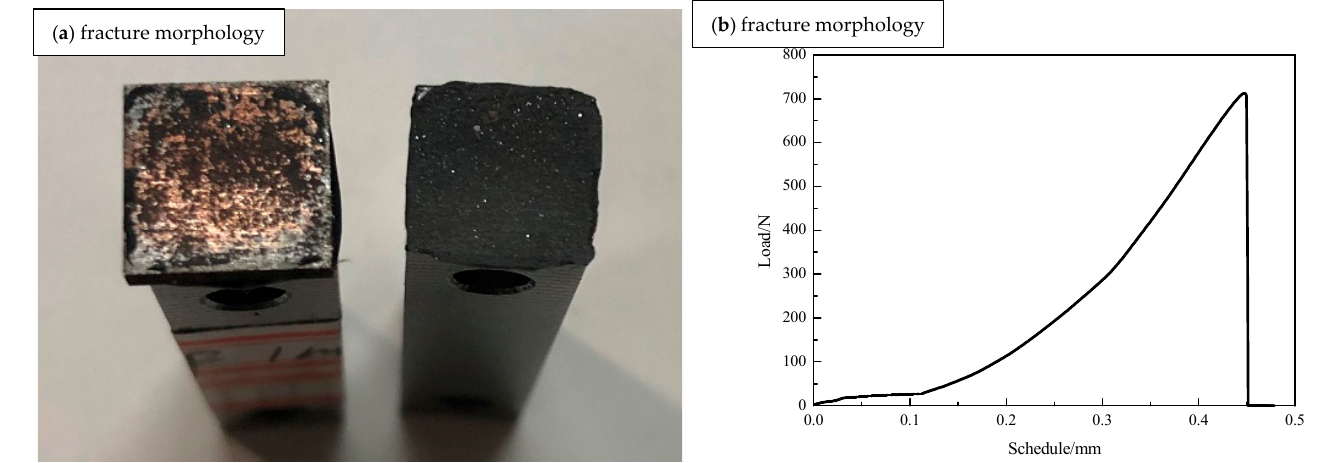
Figure 6. The bounding strength of Cu–Steel interface. It can be seen from Figure 6 that the fracture of the sample occurred on the interface between the copper layer and the strong adhesive, and the load before the fracture was once more than 700 N, indicating that the bonding strength of the copper–steel transition layer was great. This shows that in the continuous casting process, the copper that has been attached to the surface of the steel substrate will not be peeled off due to the mechanical extrusion of the secondary cold roll and the erosion of the secondary cold water, and the extrusion of the secondary cold roll will also aggravate the expansion of copper on the